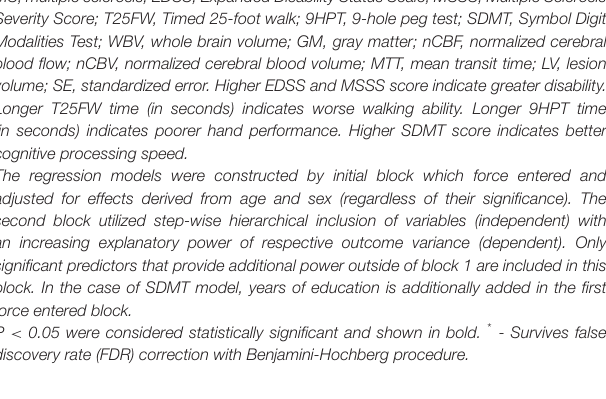
population are shown in Table 1 . A total of 103 MS patients was composed of 63 CIS/RRMS (6 CIS and 57 RRMS) and 40 PMS individuals and had an average age of 54.5 years, disease duration of 21.1 years, 5-year relapses rate of 0.155, median disability EDSS score of 3.0 and median MSSS score of 2.26. In particular, the median T25FW and 9HPT